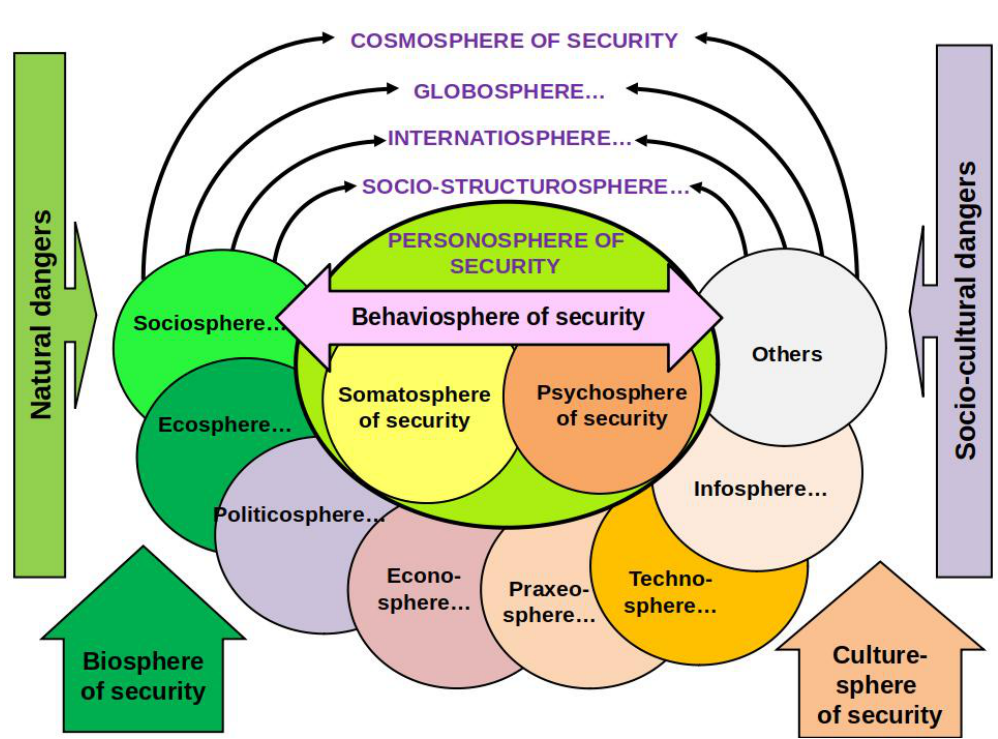
Figure 4. Anthroposphere of security: